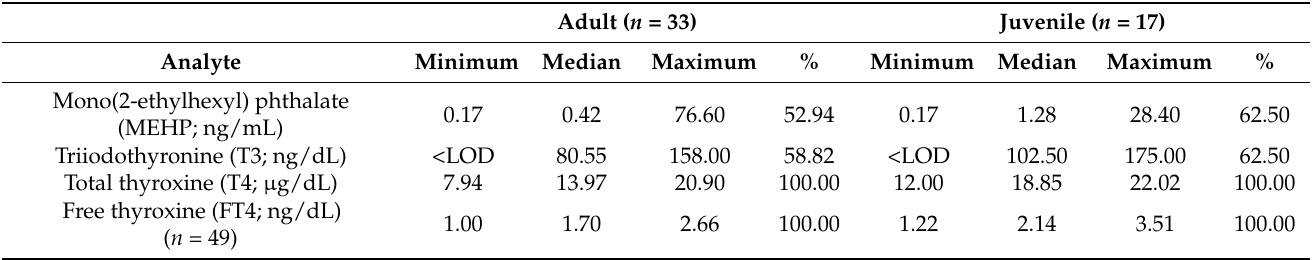
Table 3. Comparison of MEHP and thyroid hormone concentrations by age class for individual dol- phins ( n = 50 unless otherwise specified) sampled from Sarasota Bay, Florida (2010–2019). Frequency of detection given as %.